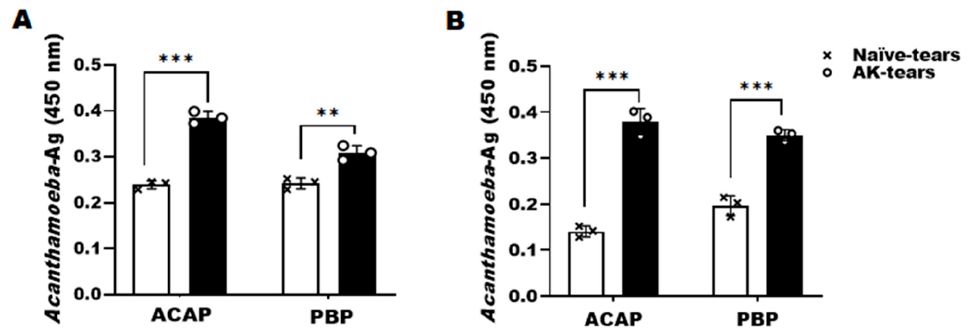
Figure 3. Detection of Acanthamoeba antigens in tears. The tears of the AK mouse model were collected after 7 ( A ) and 21 ( B ) dpi with A. castellanii . The detection of Acanthamoeba antigens in tears was evaluated by ACAP and PBP antibodies of A. castellanii . Negative ( × ); naïve tears, positive ( ○ ); AK-mouse tears. Data are expressed as mean ± SD and asterisks denote statistical significance between the means of the two groups (** p < 0.01 and *** p <